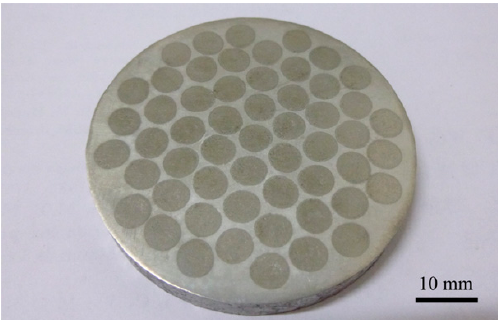
Figure 3. Macrograph of the CTC P -NiCrBSi/heat resistant steel composite layer fabricated.